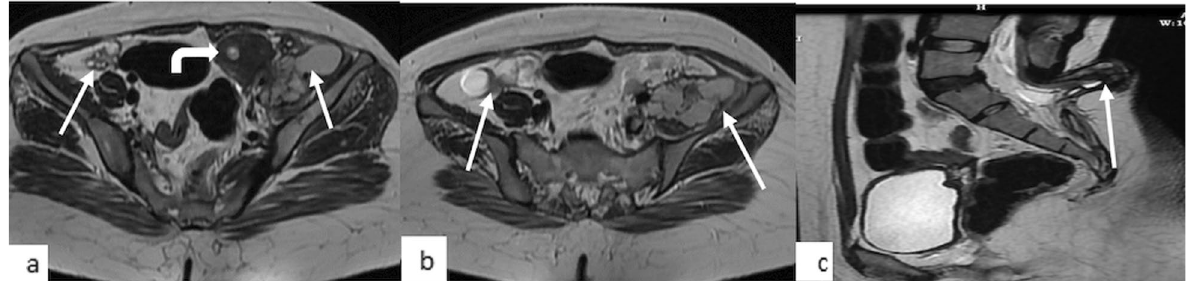
Fig. 4 ( a – c ) A 20-year-old female with type II MRKH syndrome ( a ), ( b ) Axial T2 WI showing unilateral left uterine bud in extrapelvic location [Curved arrow in ( a )]with three layered differentiation. Bilateral ovaries can be seen in extrapelvic location with left ovary containing endometriomas [Straight arrows in ( a ) and ( b )]. c T2 sagittal image showing sacral dorsal dermal sinus (Straight